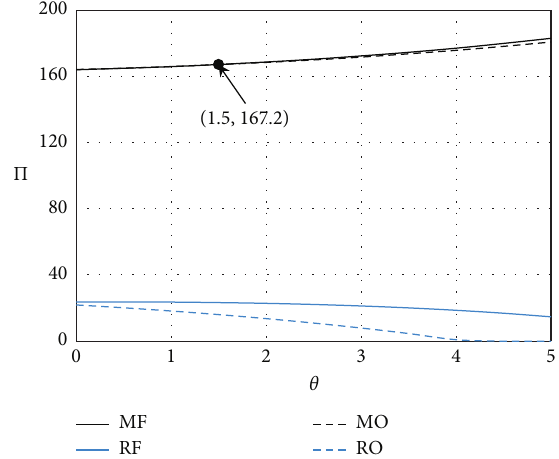
Figure 7: Impact of carbon sensitivity coefficient on profits in farsighted and myopic cases.